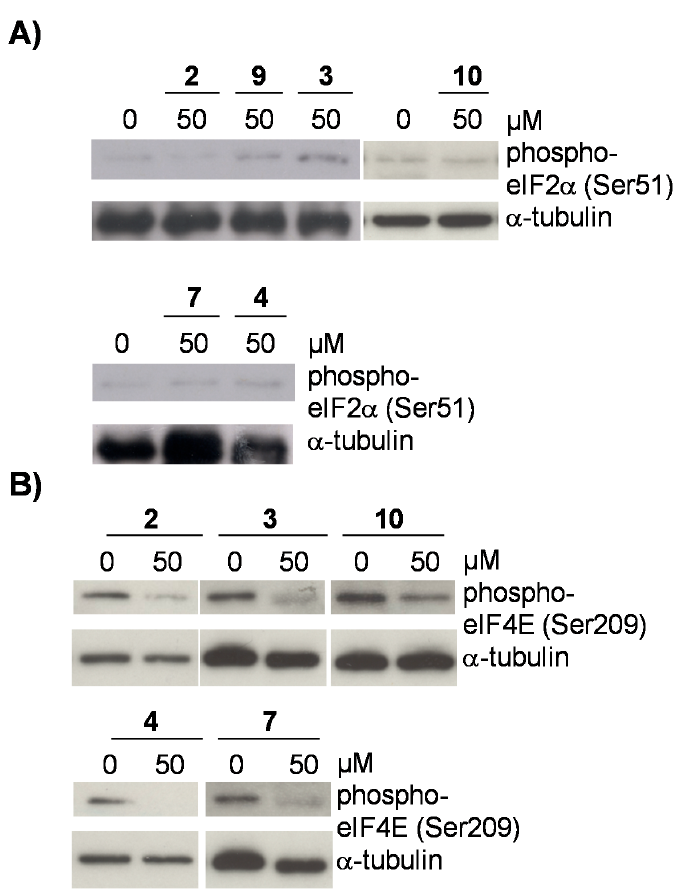
Figure 5. Effect of flavonoids 2 – 4 , 7 , 9 , and 10 on translational initiation. Phosphorylation of eIF2alpha at serine 51 or eIF4E at serine 209 was analyzed in lysates of cells, pretreated with 50 μ M of the indicated flavonoids for 6 h by immunoblotting. Immunoblots were reprobed for α‐ tubulin to visualize that similar amounts of proteins were analyzed in each sample. Representative blots are shown ( n = 3).